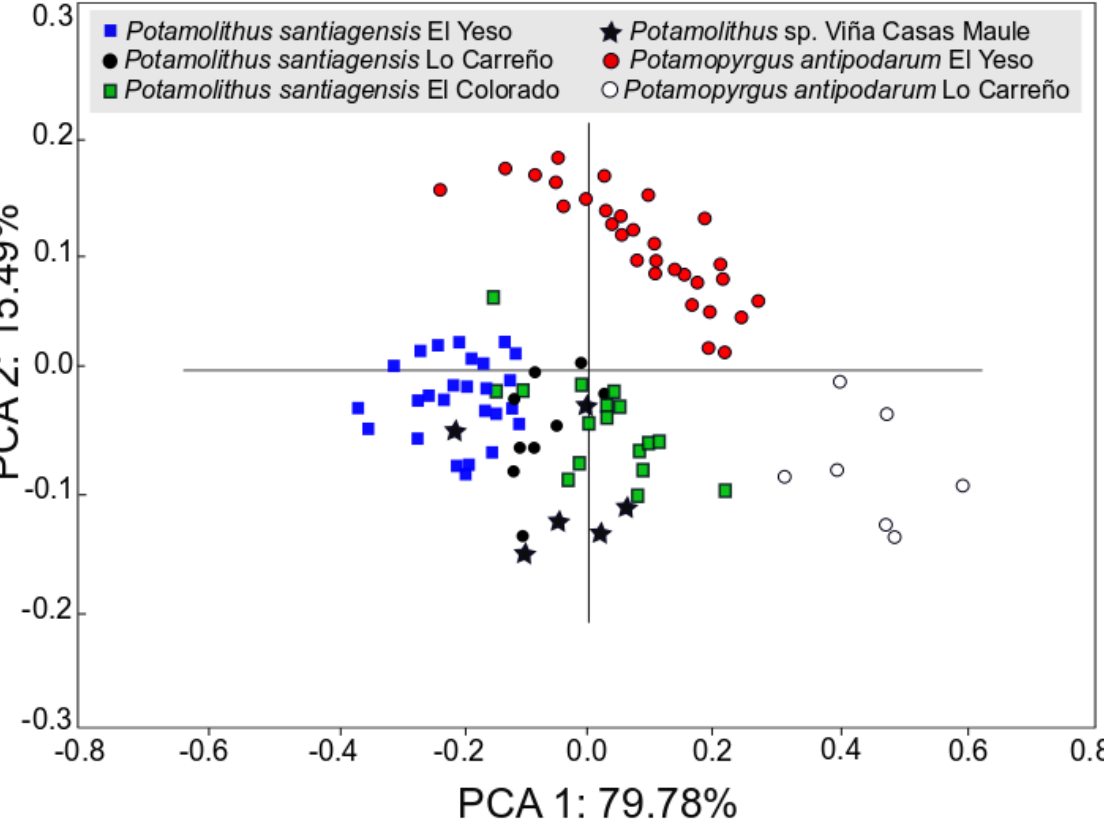
Fig. 4. PCA of Potamolithus populations and Potamopyrgus antipodarum (Gray, 1843) collected from central